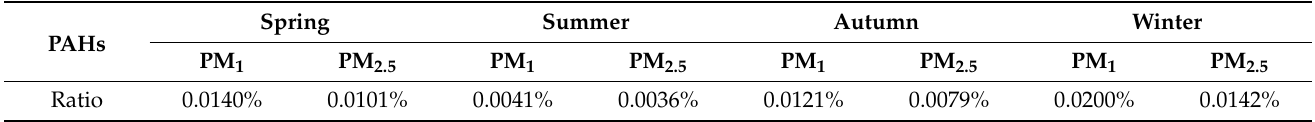
Table 1. Percentage of PAHs in PM 1 and PM 2.5 in four seasons.